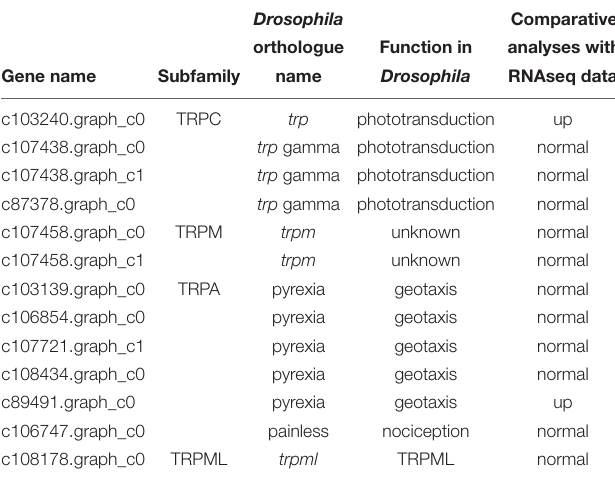
TABLE 2 | TRP channel genes in the B. lasus transcriptome.